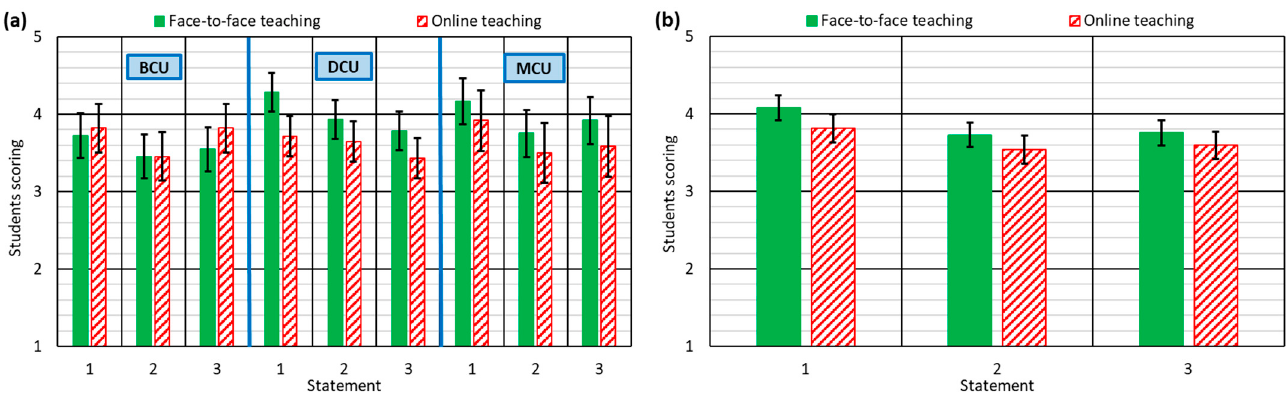
Figure 1. Student responses to statements 1–3: ( a ) for each type of course unit; ( b ) for all course